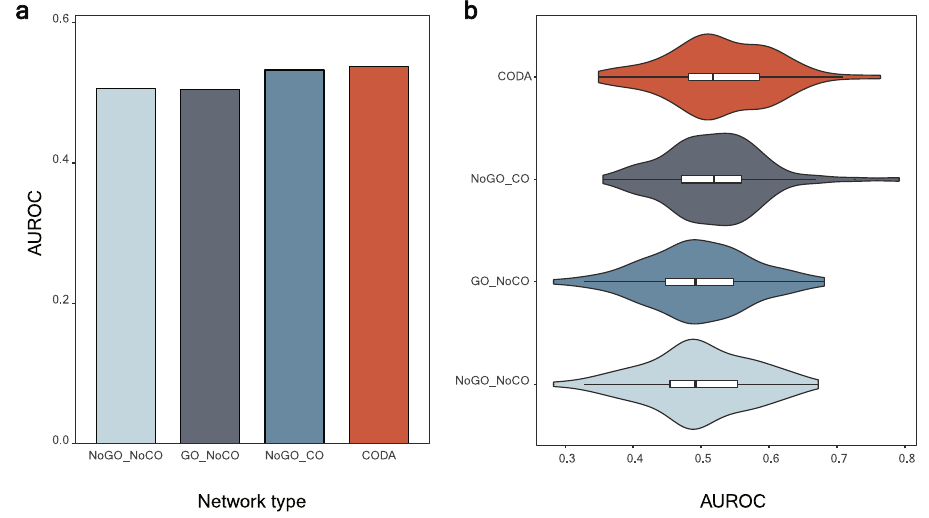
Figure 2. Performance comparison of CODA with other networks. ( a ) A bar graph for average AUROC values of inferring drug-disease relationships by using the four kinds of networks is shown. ( b ) A violin plot for AUROC values of inferring drug-disease relationships by using the four networks is revealed.